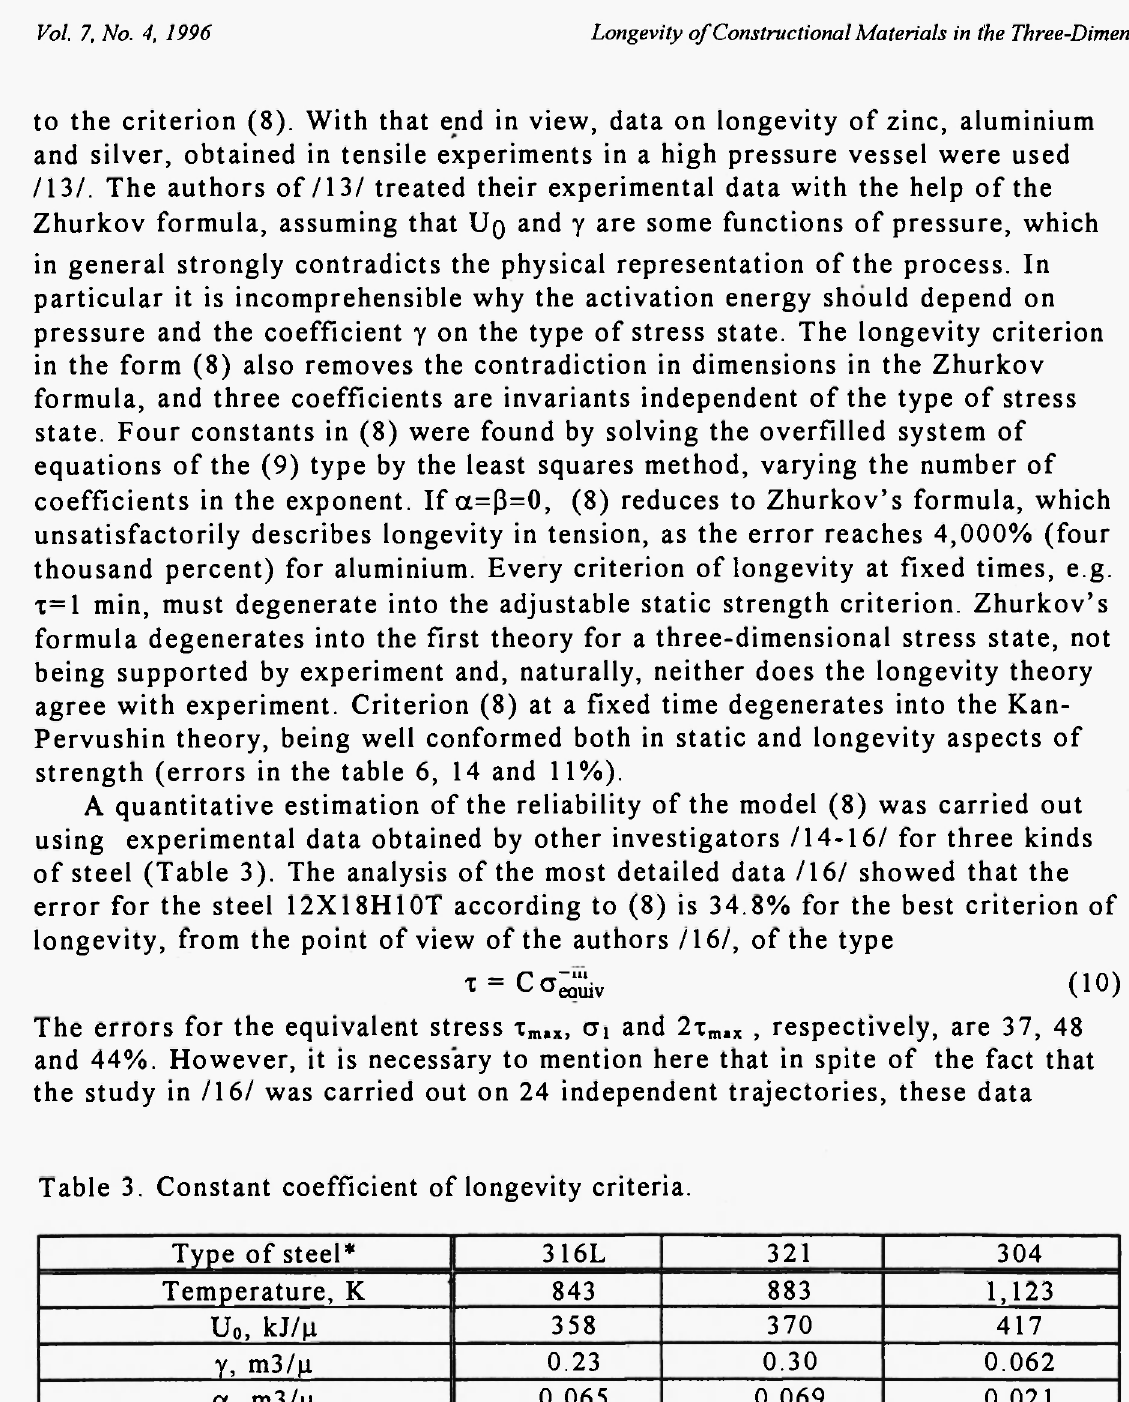
Table 3. Constant coefficient of longevity